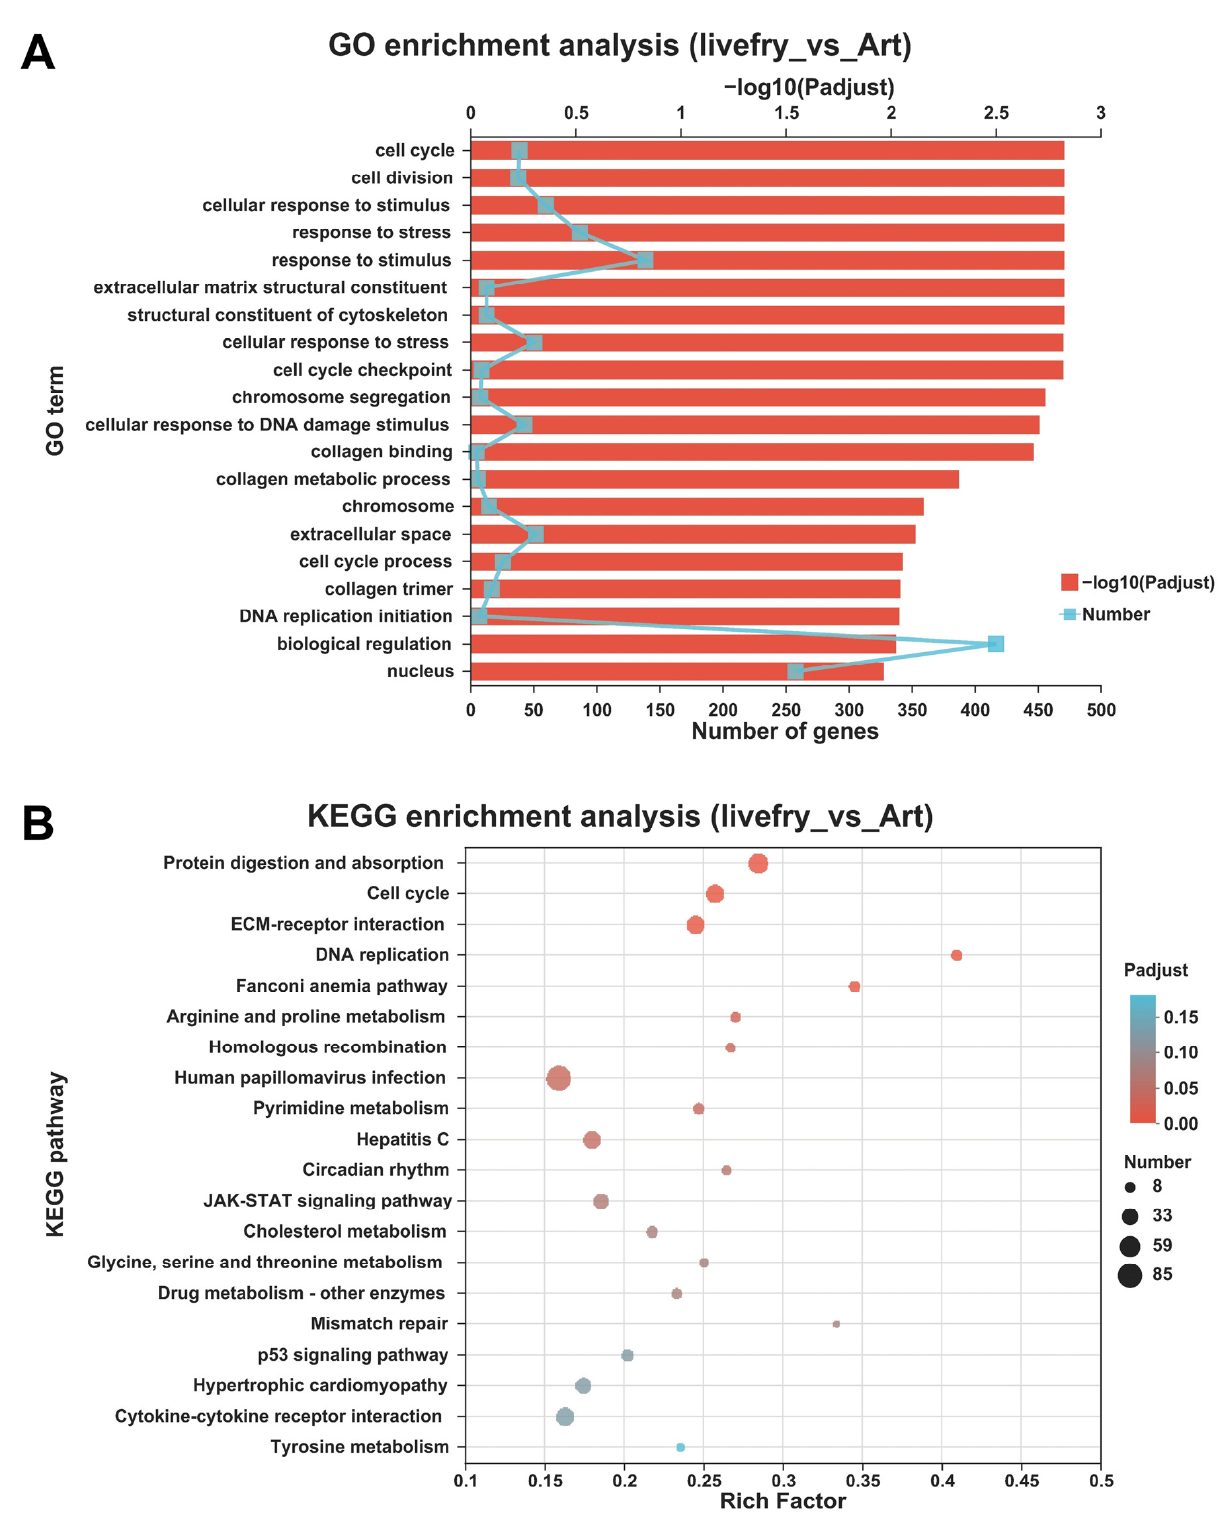
Figure 2. Functional enrichment analyses of DEGs between the mandarin fish larvae fed with live prey fish and brine shrimp. ( A ). Top 20 GO enrichment terms; ( B ). Top 20 KEGG enrichment